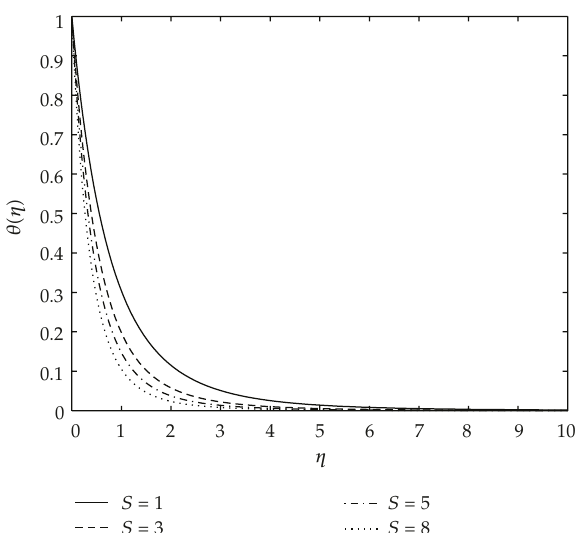
Figure 11: Temperature profiles for various values of S with M (cid:5) 1, Pr (cid:5) 0 . 72, m (cid:5) 1, β 2 (cid:5) 0 . 1, and β 1 (cid:5) 0 . 1 .